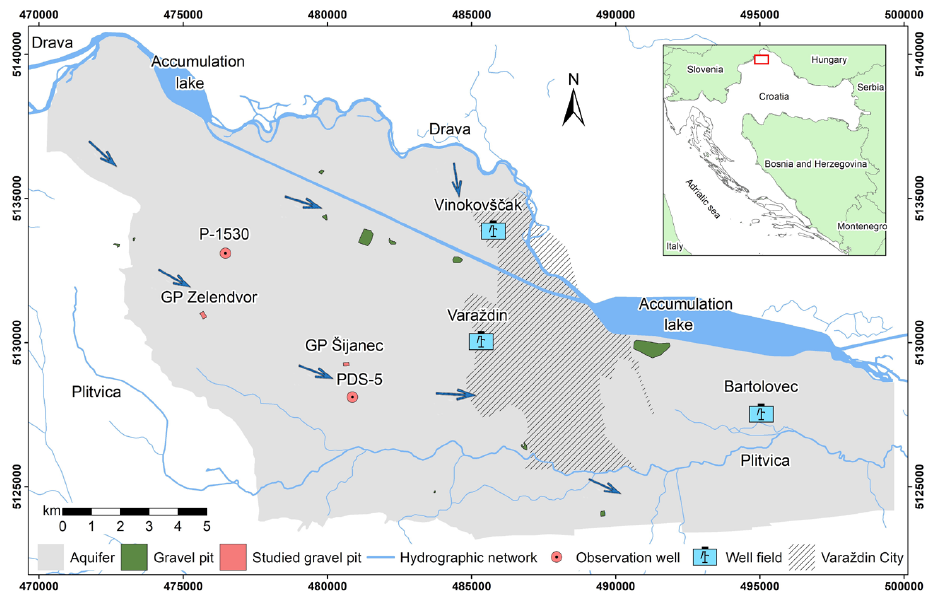
Figure 1. Geographical position of the study area with indicated locations of the investigated gravel pits and observation wells. Blue arrows indicate groundwater flow direction according to Karlović et al. [13].